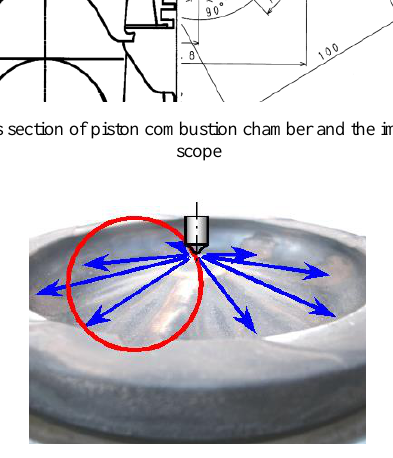
Fig. 4. Observation area in combustion chamber